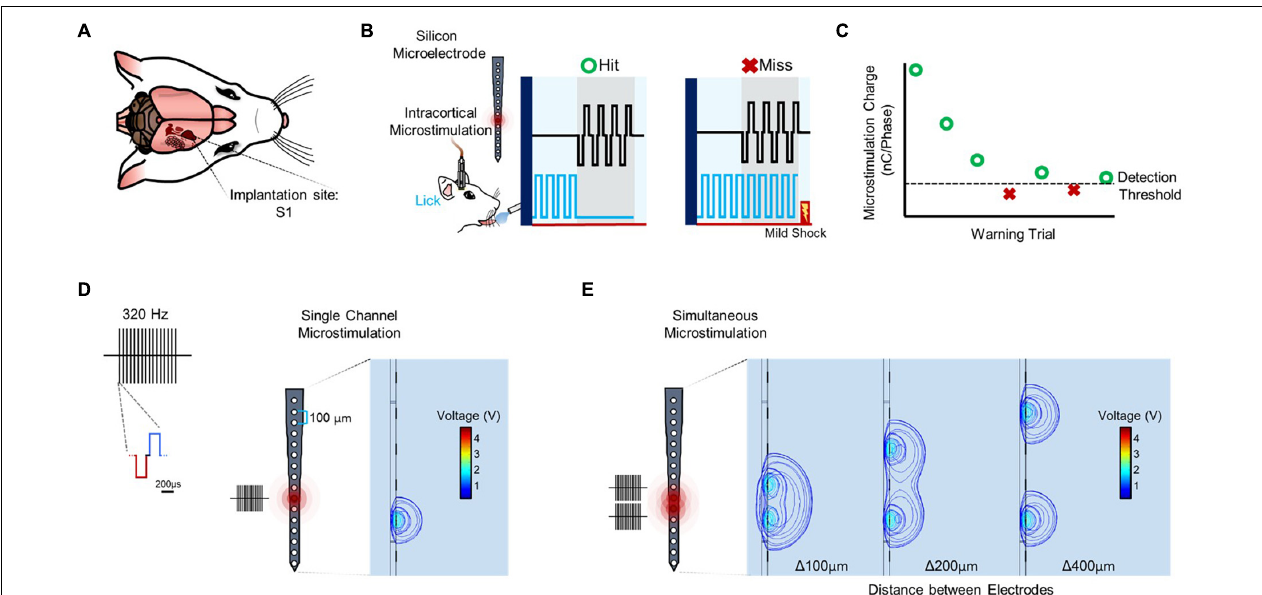
FIGURE 1 | Experimental setup and stimulation paradigm. (A) Rat implanted in primary somatosensory cortex (S1). (B) Subjects trained in a conditioned avoidance behavioral paradigm in which they are trained to stop licking from a spout with a detector when they feel a stimulus. Every time the subject correctly ceases licking (hit) the amplitude of the stimulus decreases. Conversely, when the subject fails to detect the stimulus (miss) a mild electrical shock is released at the spout and the amplitude of the stimulus increases. (C) Trials for a particular set of stimulation parameters are continued until three reversals are detected (miss to hit, hit to miss, miss to hit), at which point the average amplitude of the last five trials are averaged and determined to be the detection threshold. (D) Stimulation is delivered from one or more sites spaced 100 µ m apart on an electrode shank with sites spanning cortical depth. Each stimulus consists of a 320 Hz train of biphasic, charge-balanced waveforms with a pulse width of 200 µ s and variable amplitude. (E) Stimulation sites are combined by stimulating from multiple channels simultaneously to obtain data on simultaneous microstimulation